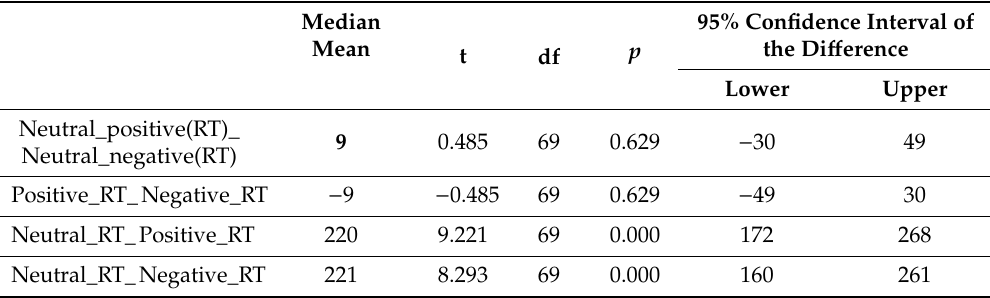
Table 1. E ff ect of performance